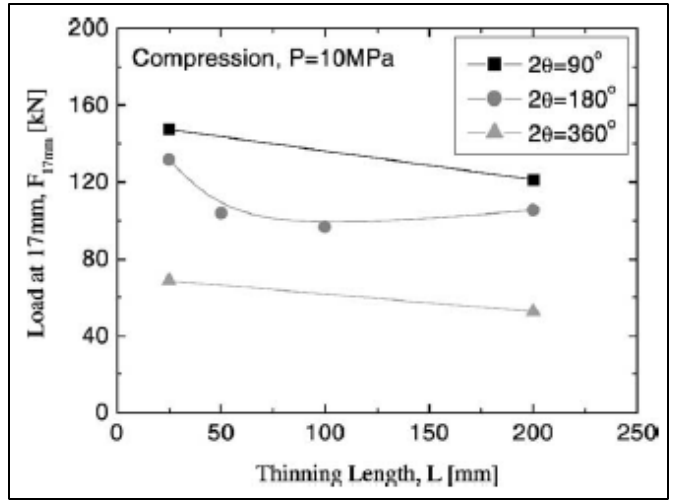
Figure 6. Graph representing the varying axial defect length subjected to internal pressure and external forces and its effect on pipe load-carrying capacity [58].